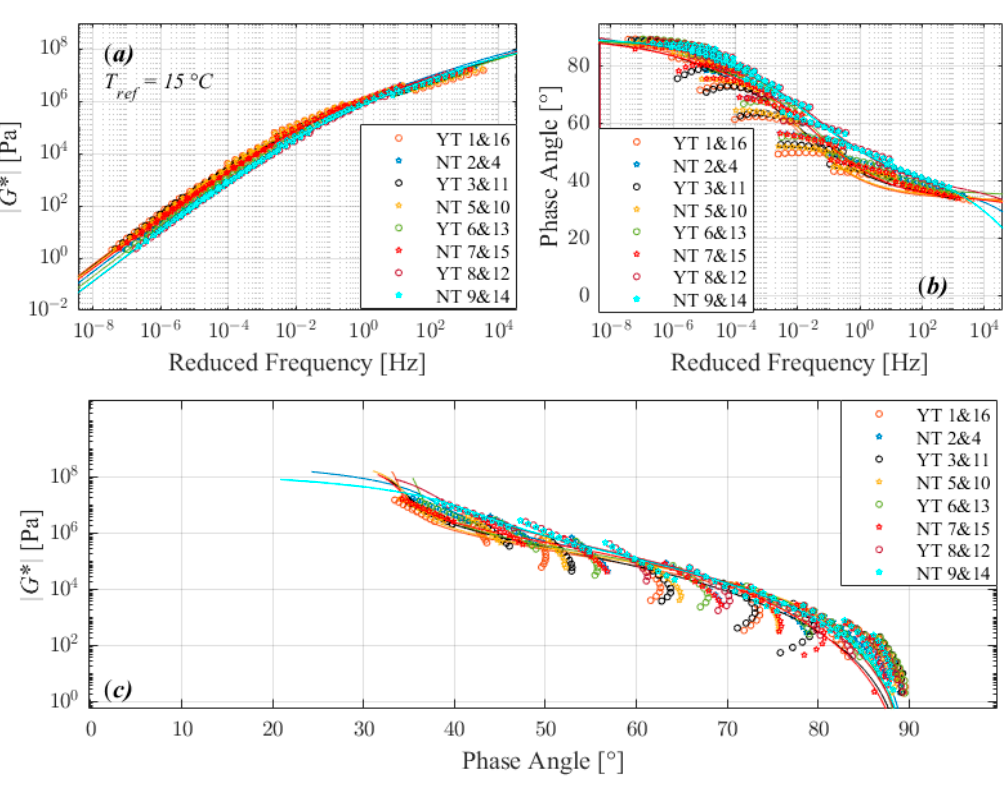
Figure 5. Comparison of master curves of complex shear modulus ( a ), phase angle ( b ), and black diagram ( c ) for